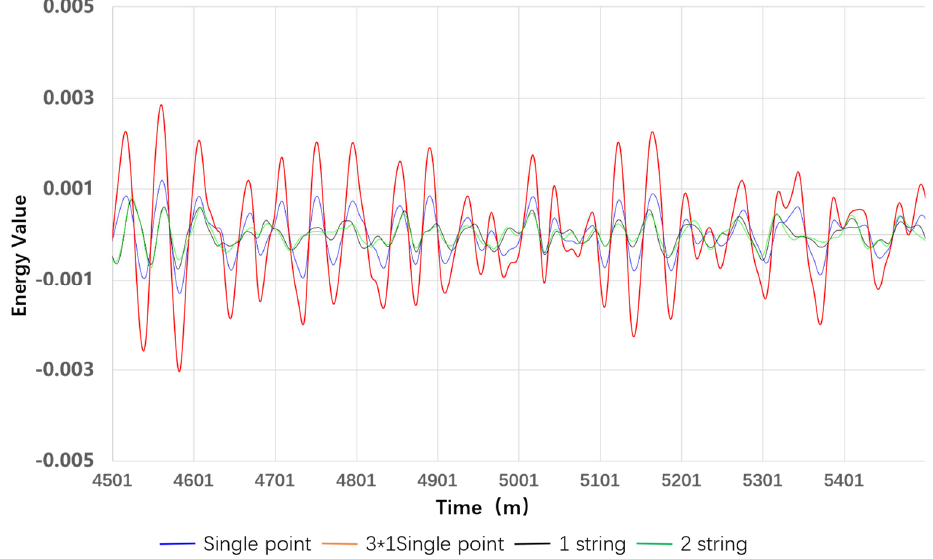
Figure 7. Comparison of different geophones in the true amplitude of the target layer. Table 1. Main technical parameters of commonly used geophones (including nodes).